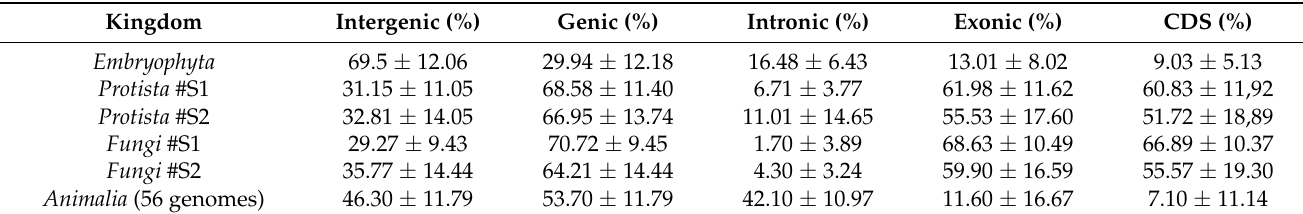
Table 1. Percentage with respect to the genome length for the genomic regions in the three kingdoms. Kingdom Intergenic (%) Genic (%) Intronic (%) Exonic (%) CDS (%)